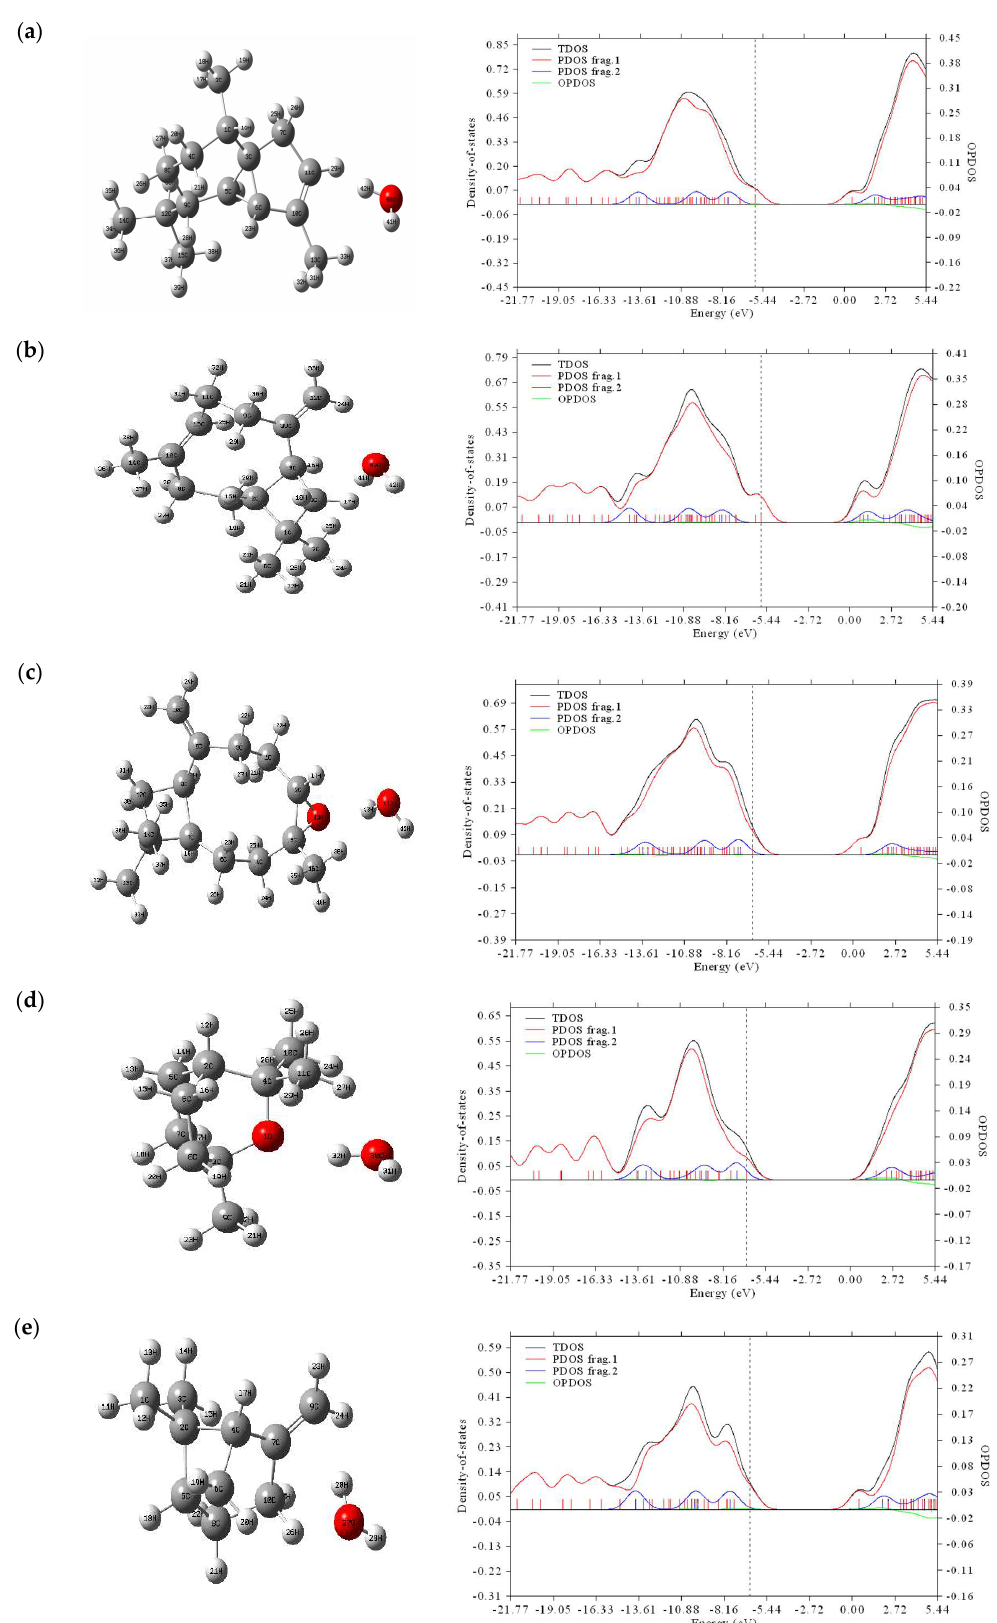
Figure 3. TDOS, PDOS, and OPDOS plots of the binary mixtures ( α -cubebene–water ( a ), β - caryophyllene–water ( b ), caryophyllene oxide–water ( c ), 1,8-cineole–water ( d ), and β-pinene–water ( e )) (frag. 1-pure molecule; frag. 2-binary mixture with water). A virtual orbital is also known as an acceptor orbital because it is not occupied. On